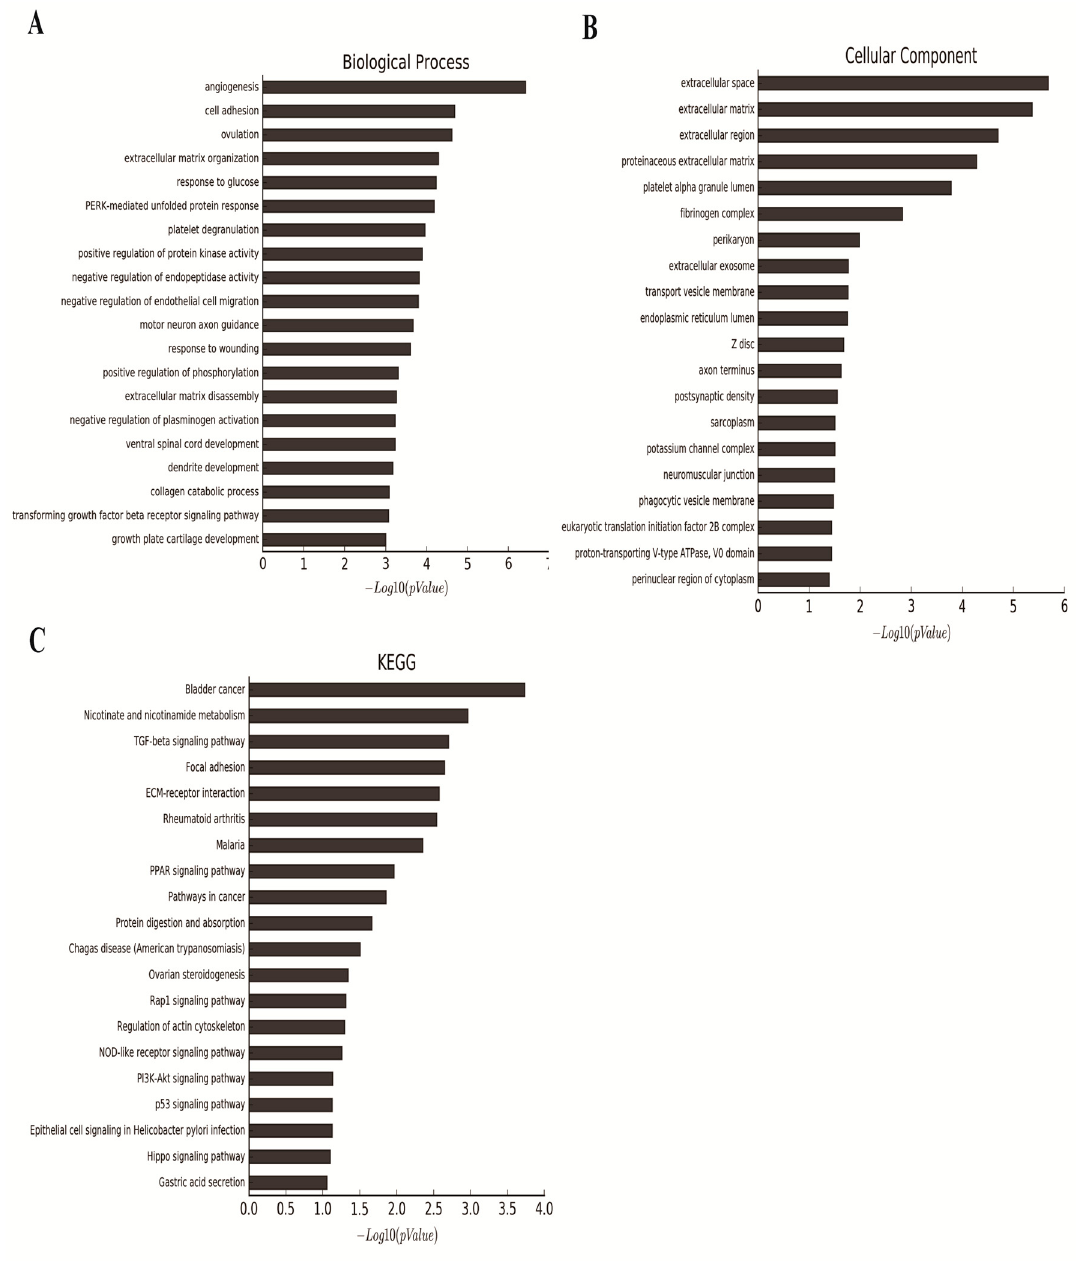
Figure 5. Genome-wide analysis of RHPN1-AS1 targets. ( A , B ) Significant GOs affected by RHPN1-AS1 silencing. X -axis, negative logarithm of the p value ( − Lg p ); Y -axis, the Gene Ontology (GO) category; ( C ) Histogram of signal pathways that were regulated by RHPN1-AS1 silencing. X -axis, negative logarithm of the p -value ( − Lg p ); Y -axis, the name of the pathway.